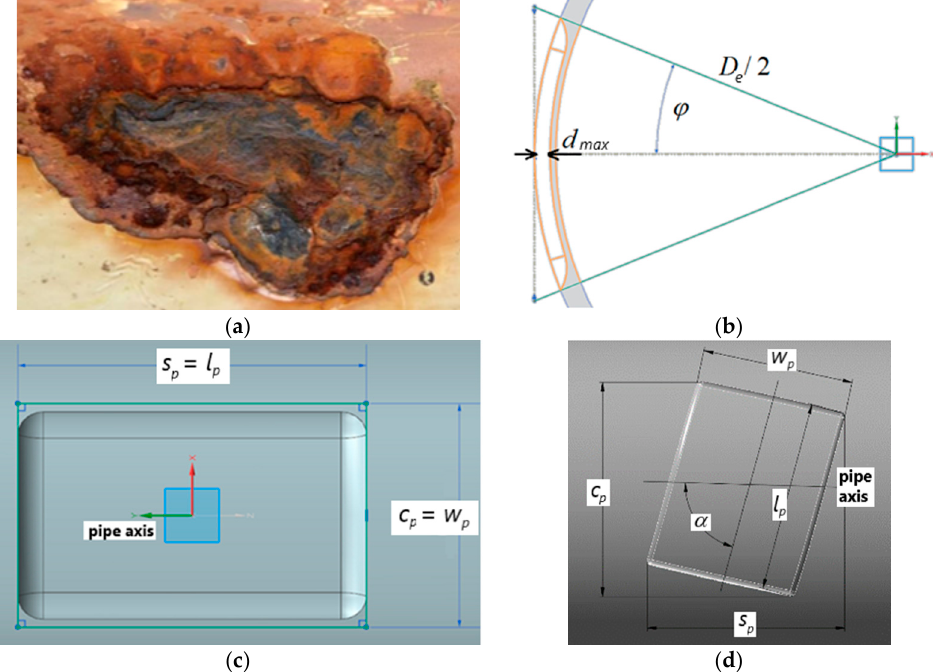
Figure 2. Typical corrosion defect in a steel pipe: ( a ). an example (before machining); ( b – d ). assumed defect geometry (after machining): ( b ). transversal section; ( c ). straight defect (front view); ( d ). inclined defect (front view); d max —maximum depth, α —inclination angle with respect to the pipe longitudinal axis; w p —actual width, l p —actual length, s p —axial/longitudinal extent, c p —circumferential extent.